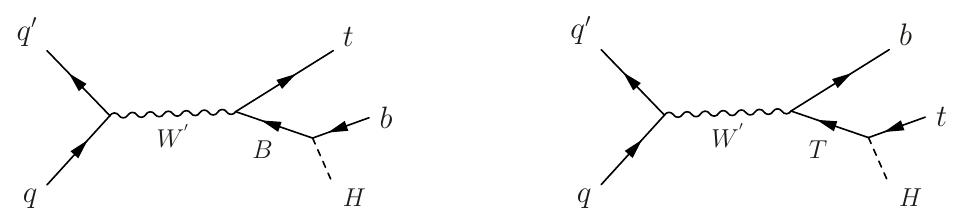
Figure 1 . The W boson production and decays considered in the analysis. The analysis assumes 0 equal branching fractions for W boson to tB and bT and 50% for each VLQ to 0